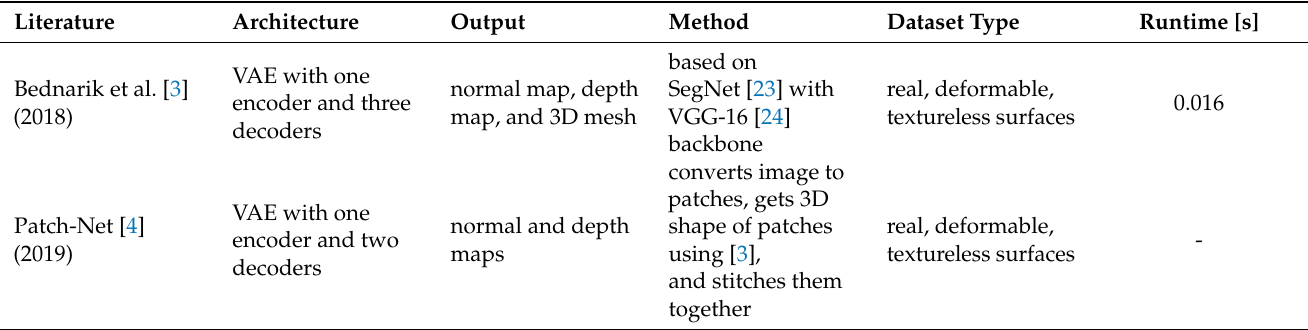
Table 3. Summary of all 3D reconstruction networks discussed in this